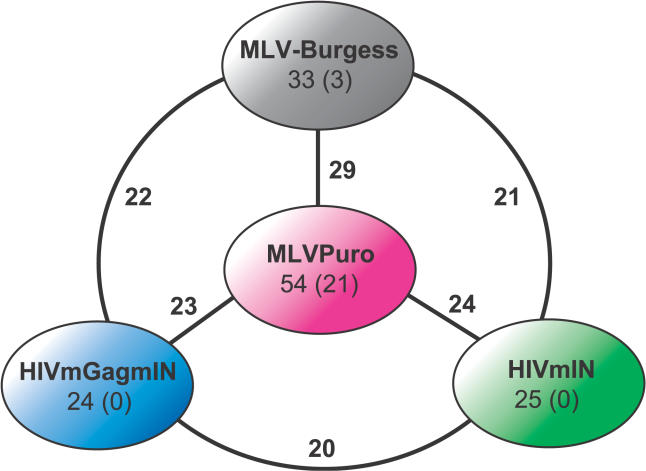
Diagram of the Relationship of Transcription-Factor Binding Sites Enriched in the MLVPuro, MLV-Burgess, HIVmIN, and HIVmGagmIN Integration-Site DatasetsThe genomic sequences within 1 kb of each integration site were used for analysis. Ten matched random-control integration sites were compared to each experimental integration site. The cut-off value for over-representation was 2.0-fold. All comparisons achieved p ≤ 0.001. The number of enriched transcription-factor binding sites in each dataset is shown with the number of factors unique to each in parentheses. The edge labels show the number of commonly enriched sites between pairs of datasets.